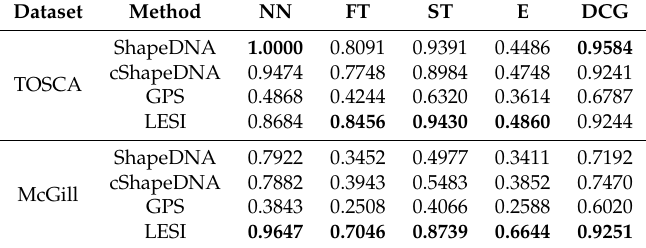
Table 1. Shape retrieval performance using TOSCA and McGill datasets.